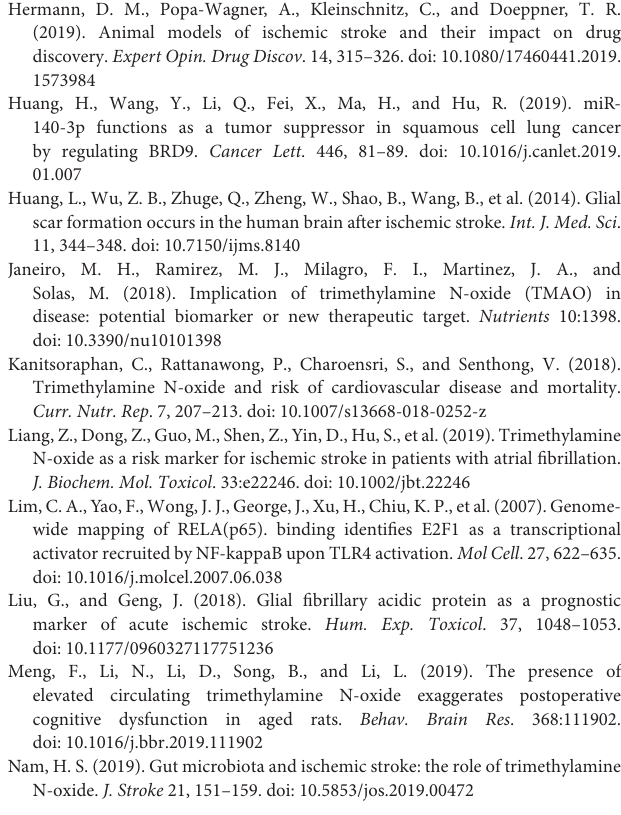
Supplementary Figure 1 | Representative images. (A) Representative images of Smurf2 expression in rat brain tissues detected by IHC assay. (B) Representative images of proliferation of cells upon different treatments detected by EdU assay. (C) Representative images of migration ability of cells upon different treatments assessed by Transwell migration assay. Supplementary Figure 2 | Representative images of IHC results of ALK5